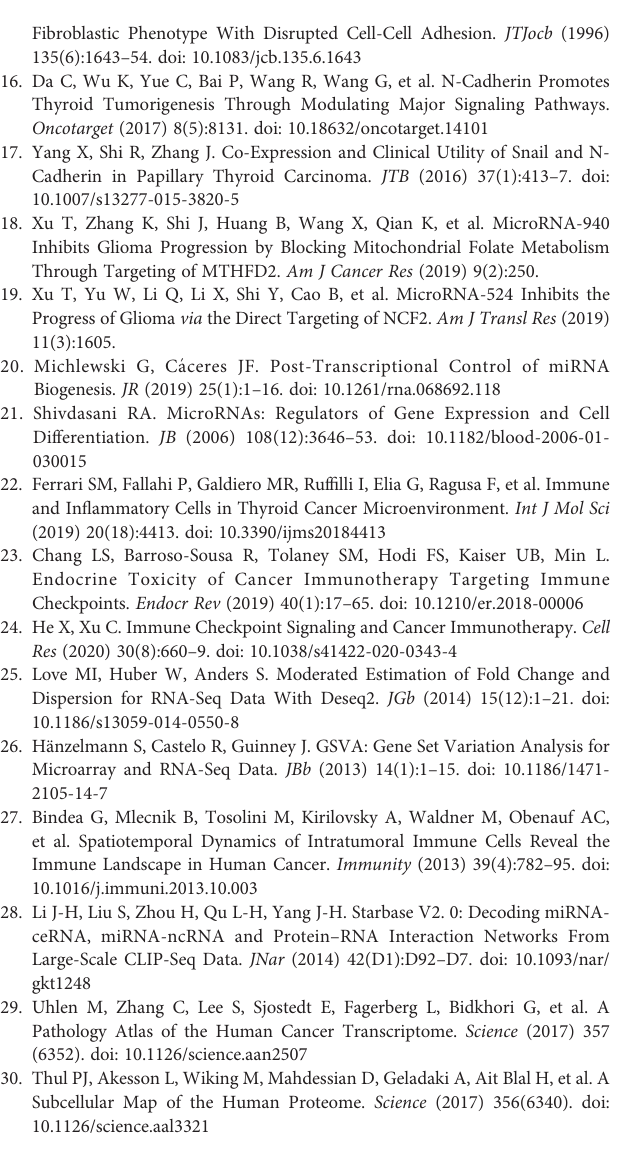
Supplementary Figure 1 | CDH2-related genes in THCA. The correlation between CDH2 and, GLT1D1, PRDM1, QPCT, NELL2 showed positive correlation. Supplementary Figure 2 | CDH2 and CDH2-related genes were correlated with EMT-related genes. Heatmap results showed that ADAMTS9, ENTPD1, FRMD3, PRR15, AKAP12 revealed strong correlations with EMT-related